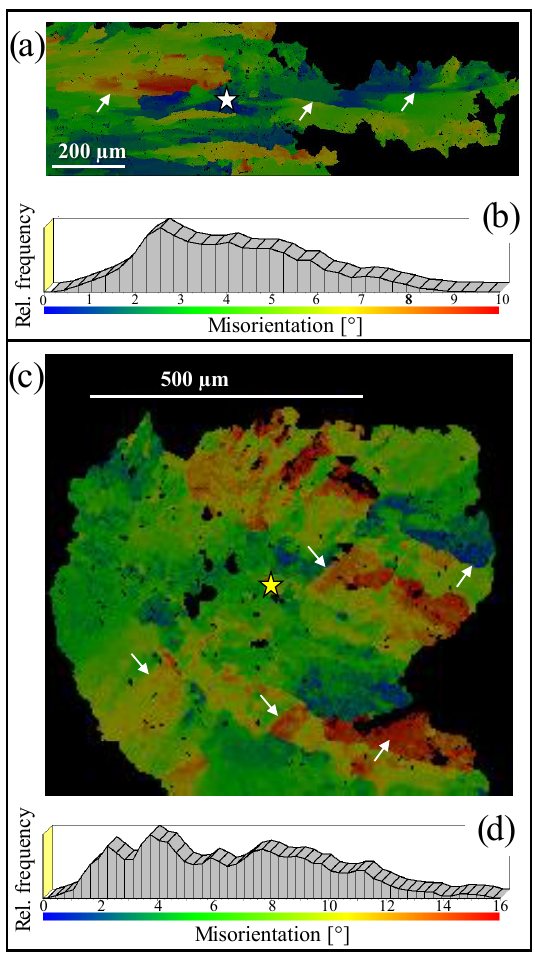
Figure 14. Colour-coded visualisation (a, c) and degree of inter- nal misorientation (b, d) within two large, millimetre-sized grains that grew in simulated burial solution at 175 ◦ C for 7 (a) and 84 (c) days. The grain shown in (a) contains some stress-free portions within its centre (indicated by blue colours and the white star in a ), while internal misorientation in the grain shown in (c) is highly in- creased and occurs everywhere within the grain (d) . The yellow star in (c) points to the region where, in this grain, stress accumulation is highest.